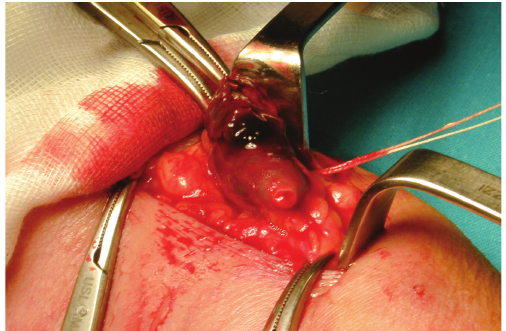
Figure 2: Intraoperative image shows the excision of cephalic vein aneurysm.